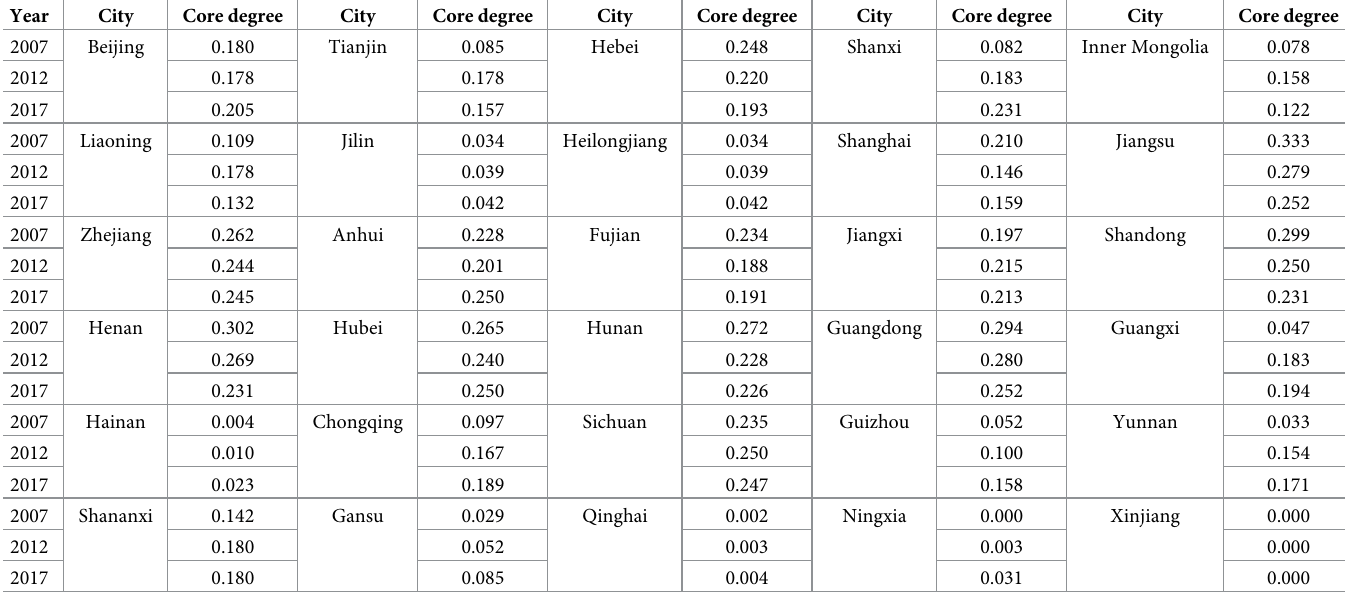
Table 5. Core degrees in 2007, 2012 and 2017.